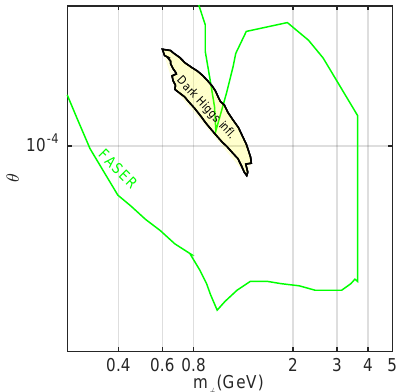
Figure 8. Left : Dark Higgs cross-section σ ϕ in the cosmological confidence region (33) at Right : FASER and MAPP reach for the dark Higgs boson with curvature corrections in the cosmolog- √ s = 13 TeV assuming 100% detection efficiency. ical confidence region (33) at